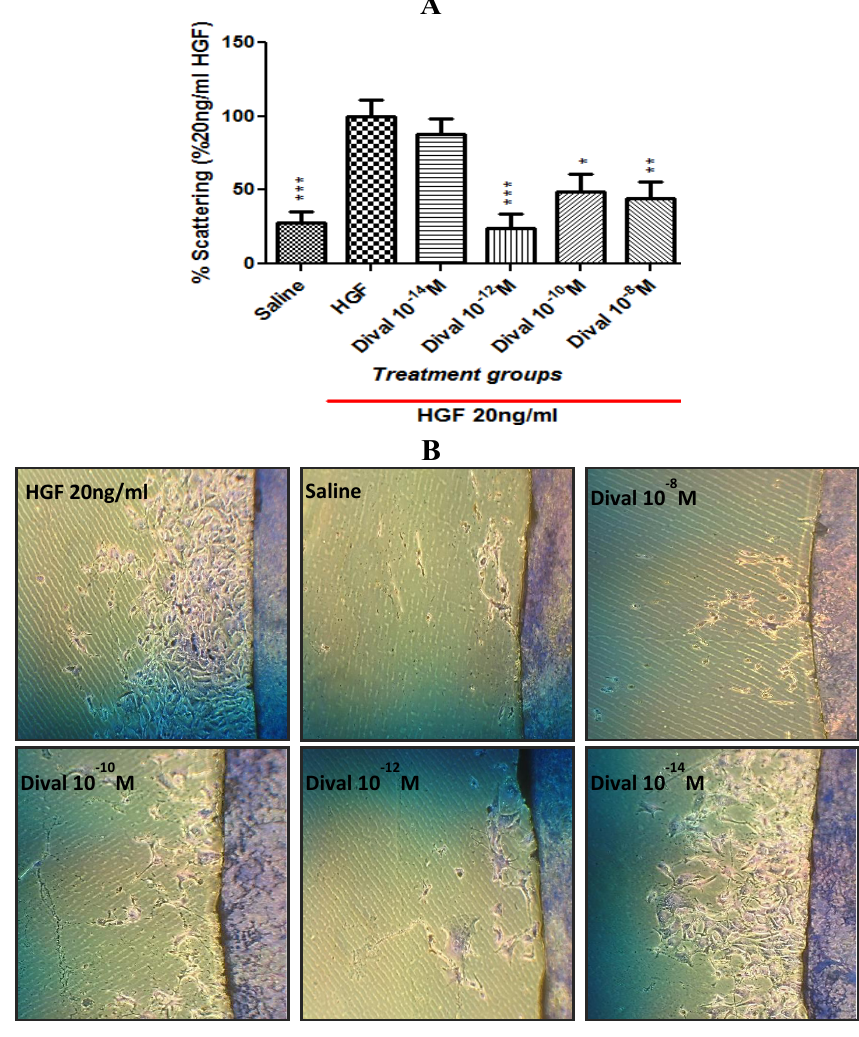
Figure 6. Divalinal inhibits HGF-dependent scattering in MDCK cells. Cell scattering in which cells lose cell-to-cell contact and then migrate is the classic response to HGF. MDCK cells are the gold standard cellular model for studying the HGF/Met system. These cells were grown to 100% confluence on coverslips and then placed on a clean plate. The cells were stimulated to scatter off of the coverslip by adding 20 ng/mL of HGF to the media alone or in combination with divalinal at 10 − 14 , 10 − 12 , 10 − 10 or 10 − 8 M. After 48 h of scattering, the cells were fixed with methanol and stained with Diff-Quik. The coverslips were removed to reveal the ring of cells that had scattered off the cover slip and onto the plate. ( A ) Quantification of HGF effect on cell scattering. Treatment groups (10 − 12 , 10 − 10 and 10 − 8 M) were statistically different than the HGF treated group (* p < 0.05, ** p < 0.01, *** p < 0.001), but not different from one another or non-treated controls ( p >